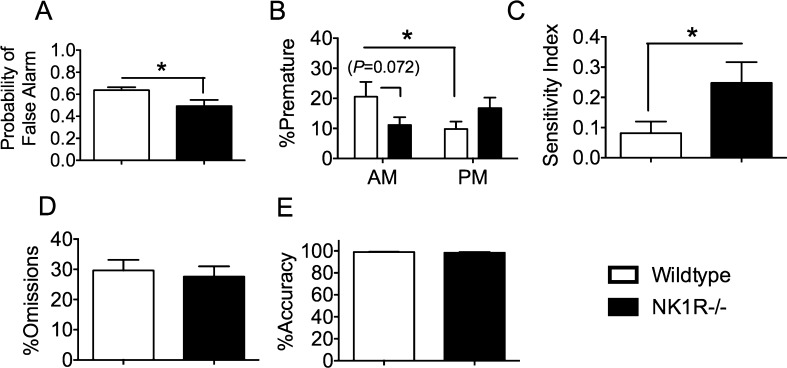
During the extended test session of the 5C-CPT (‘NI-1’), NK1R−/− mice expressed fewer false alarms and had a higher sensitivity index than wildtypes, but genotype differences in premature responses depended on time of day. Bars show mean ± s.e.m. Lines linking bars indicate statistically significant differences between groups. *P < 0.05, **P < 0.01, ***P < 0.001. N = 12 per group.